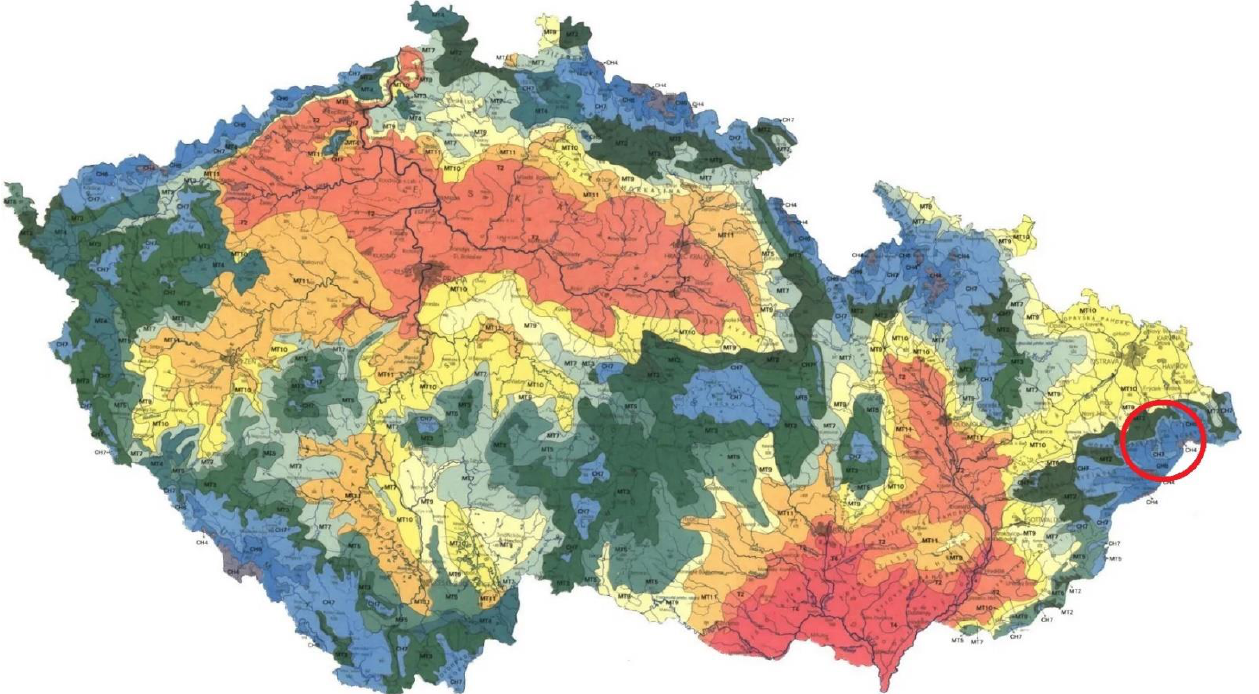
Figure 2. Climate areas according to the Quitt classification (adjusted by [15]).